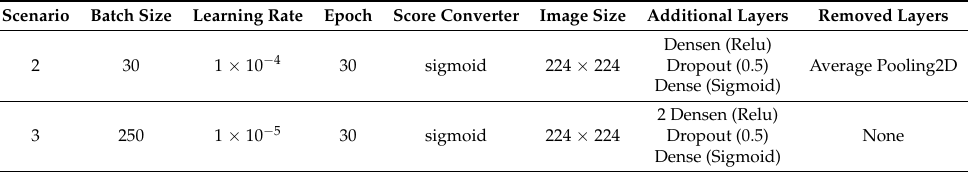
Table 5. Experimental parameters for scenarios 2 and 3.